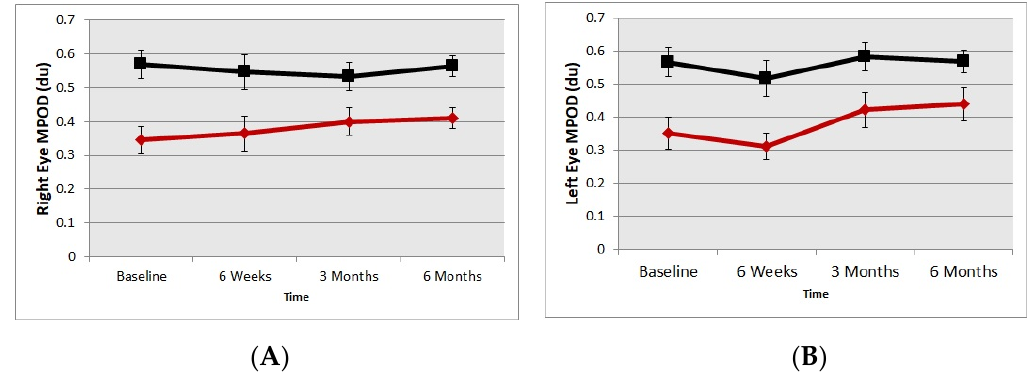
Figure 1. Macular pigment optical density change over time. A = right eye; B = left eye. The red diamond symbols represent Treatment group and black square symbols that represent the placebo group.